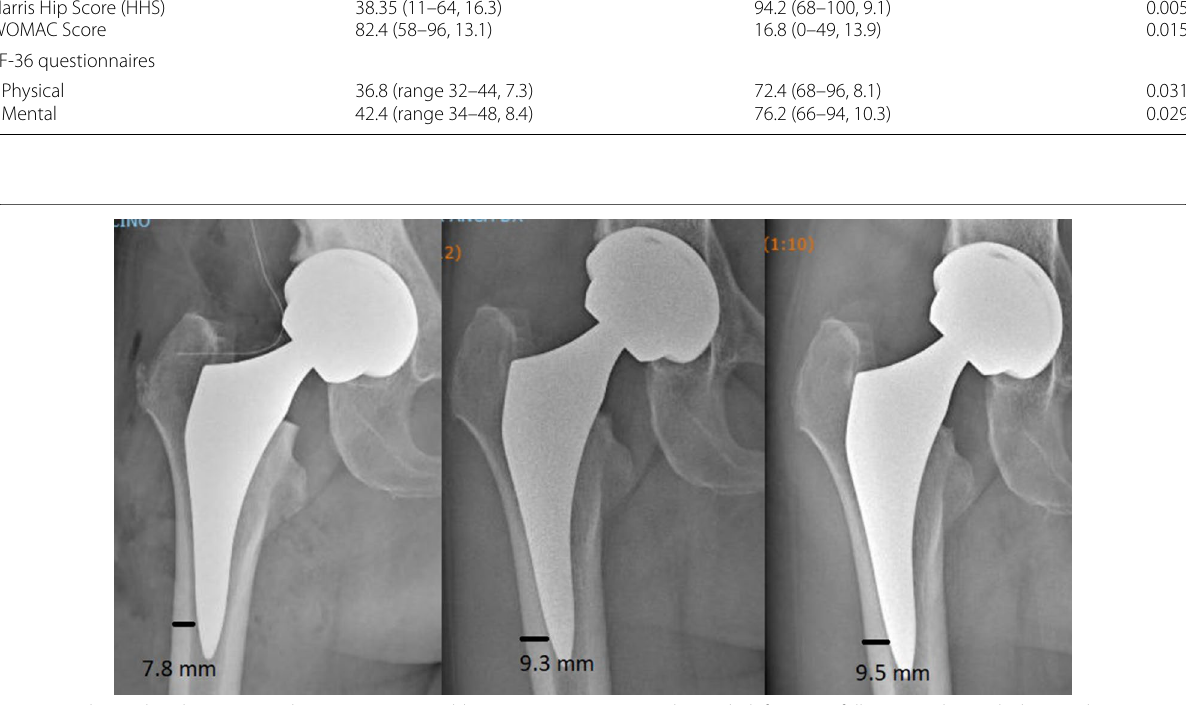
Fig. 4 Radiographic change around stem in a 62-year-old patient: postoperative radiograph (left), 1 year follow-up radiograph showing bone cortical hypertrophy in zone 3 (central), 5 years follow-up radiograph with evidence of stabilization of cortical